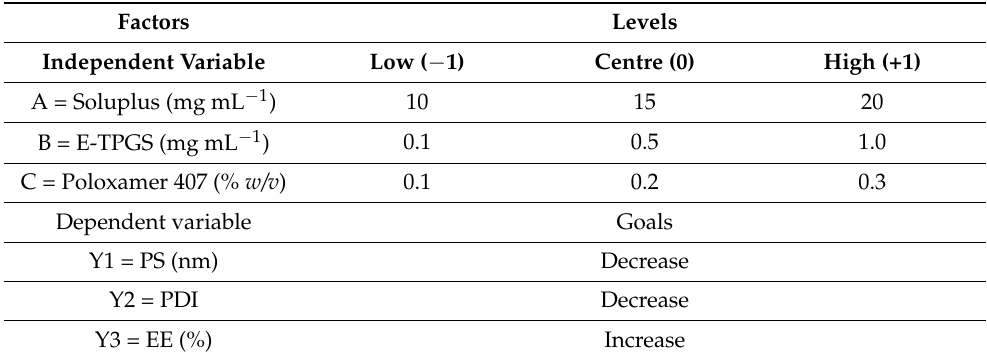
Table 1. Independent and dependent variables in Box Behnken design for preparation and optimiza- tion of